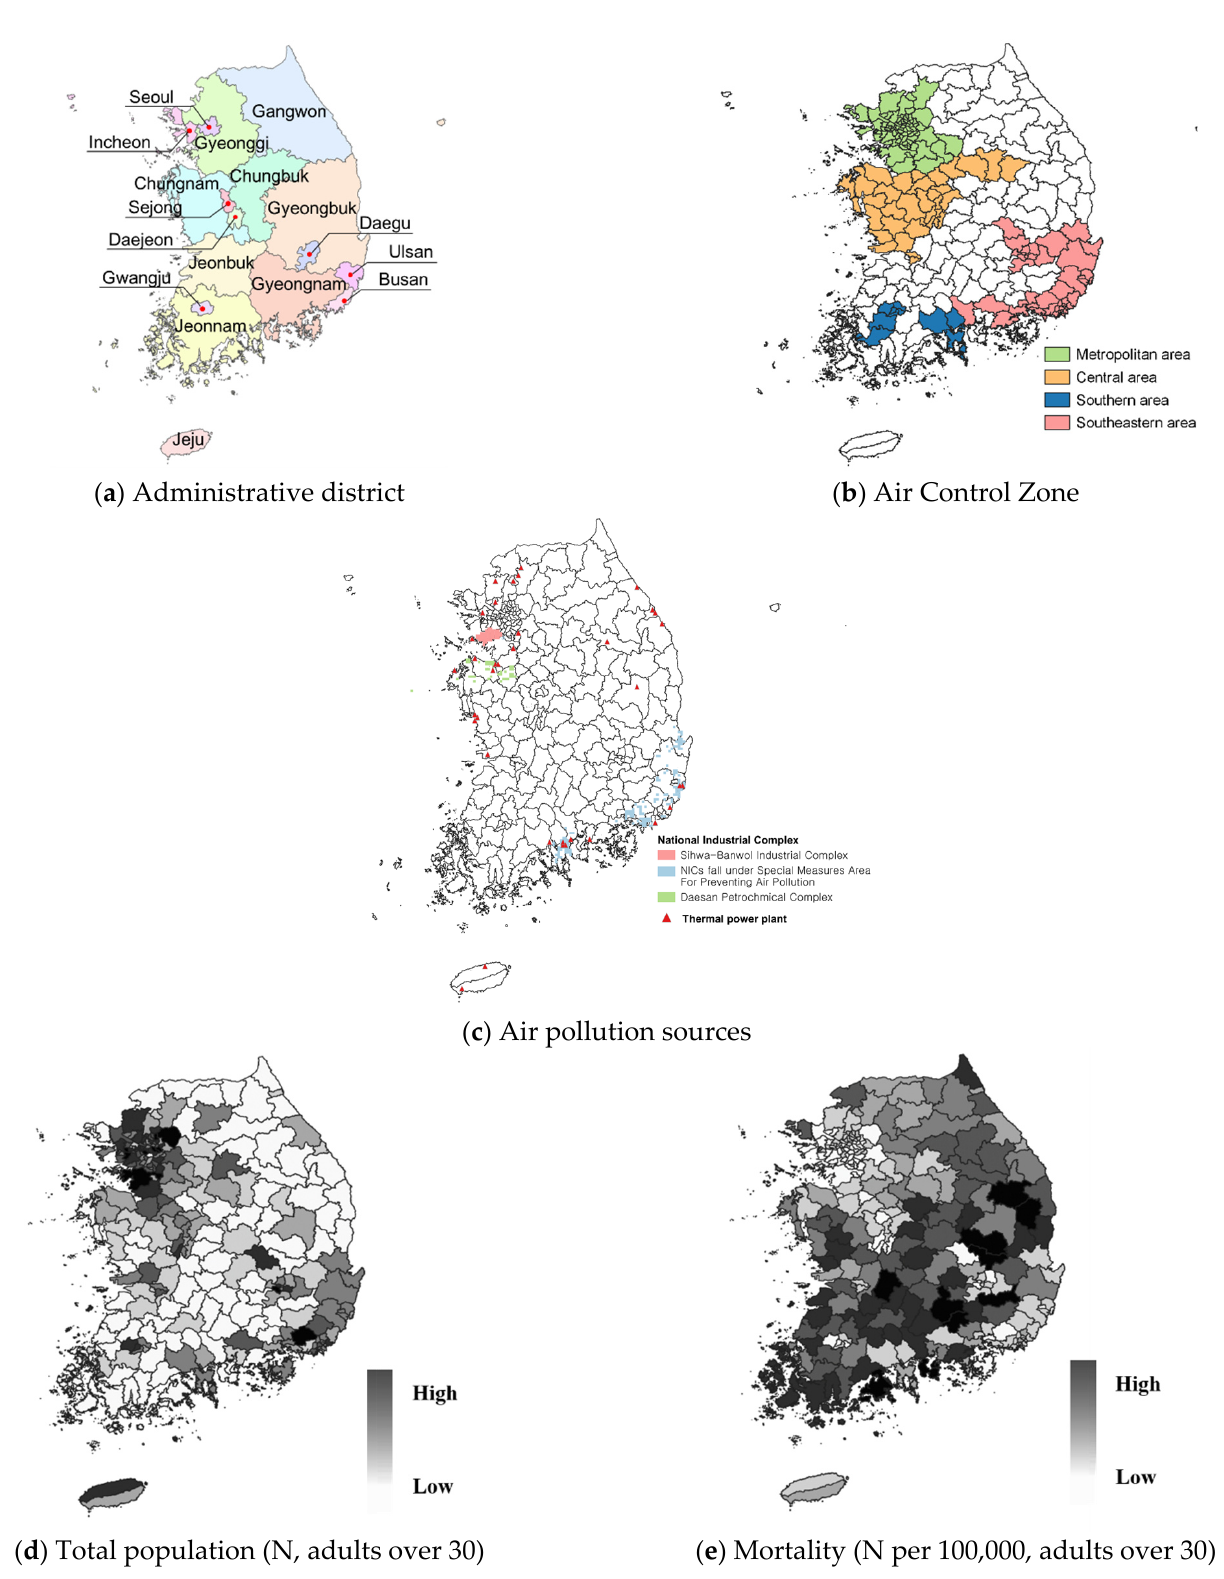
Figure 2. Distributional characteristics of the ( a ) administrative district; ( b ) Air Control Zone; ( c ) air pollution sources; and ( d ) exposed population and ( e ) mortality.